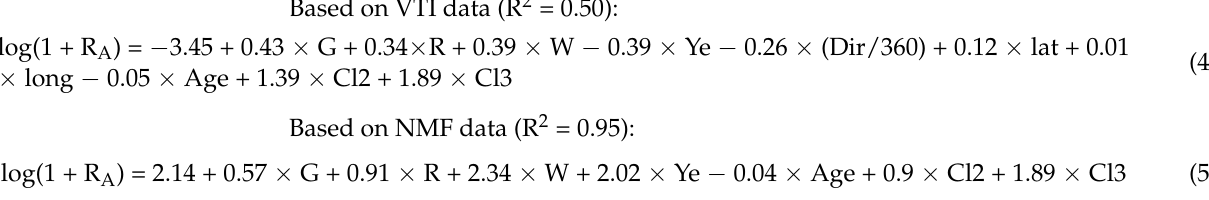
Based on VTI data (R 2 = 0.50):